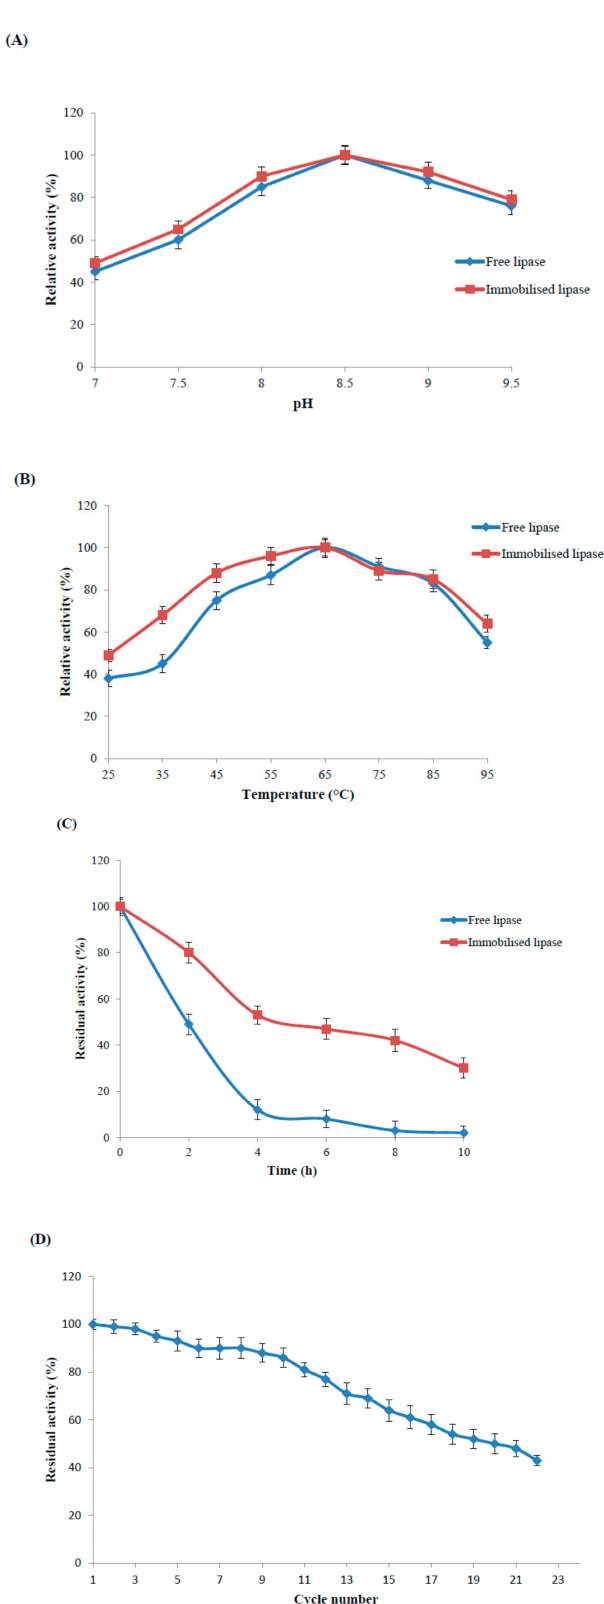
Figure 4. Catalytic activity of immobilised and free recombinant lipase as a function of pH ( A ), temperature ( B ), thermal stability ( C ) and reusability ( D ). The values are given as the mean of three experiments ± standard